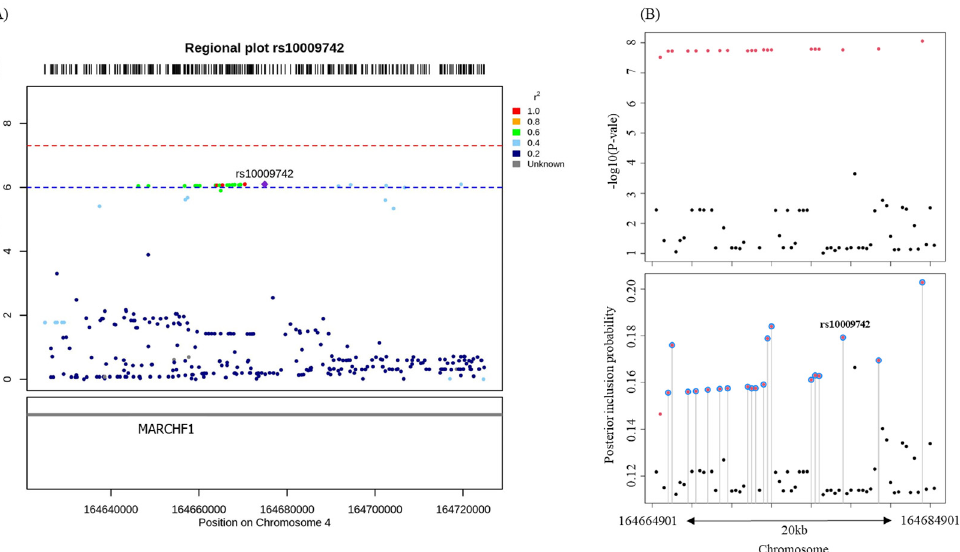
Figure 1. Genomic characteristics for the rs10009742 in 4q32.3. ( A ) Regional plot for the regions around rs10009742 in 4q32.3. The red point indicates the most strongly associated lead SNP, rs10009742 (purple diamond). ( B ) Fine-mapping results for rs10009742, illustrated by the PIP plot of fine-mapping around rs10009742 with +/ − 10 kb intervals. The SNPs around the blue circles in the plot are credible sets with a potential causality (the highest PIP was estimated for rs13127646). PIP, posterior inclusion probability; SNP, single-nucleotide polymorphism.